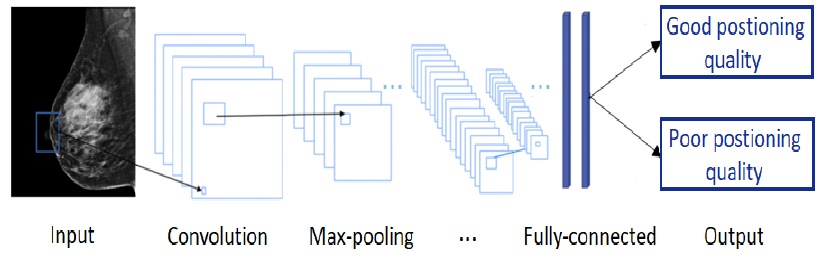
Figure 15. A typical convolutional neural network